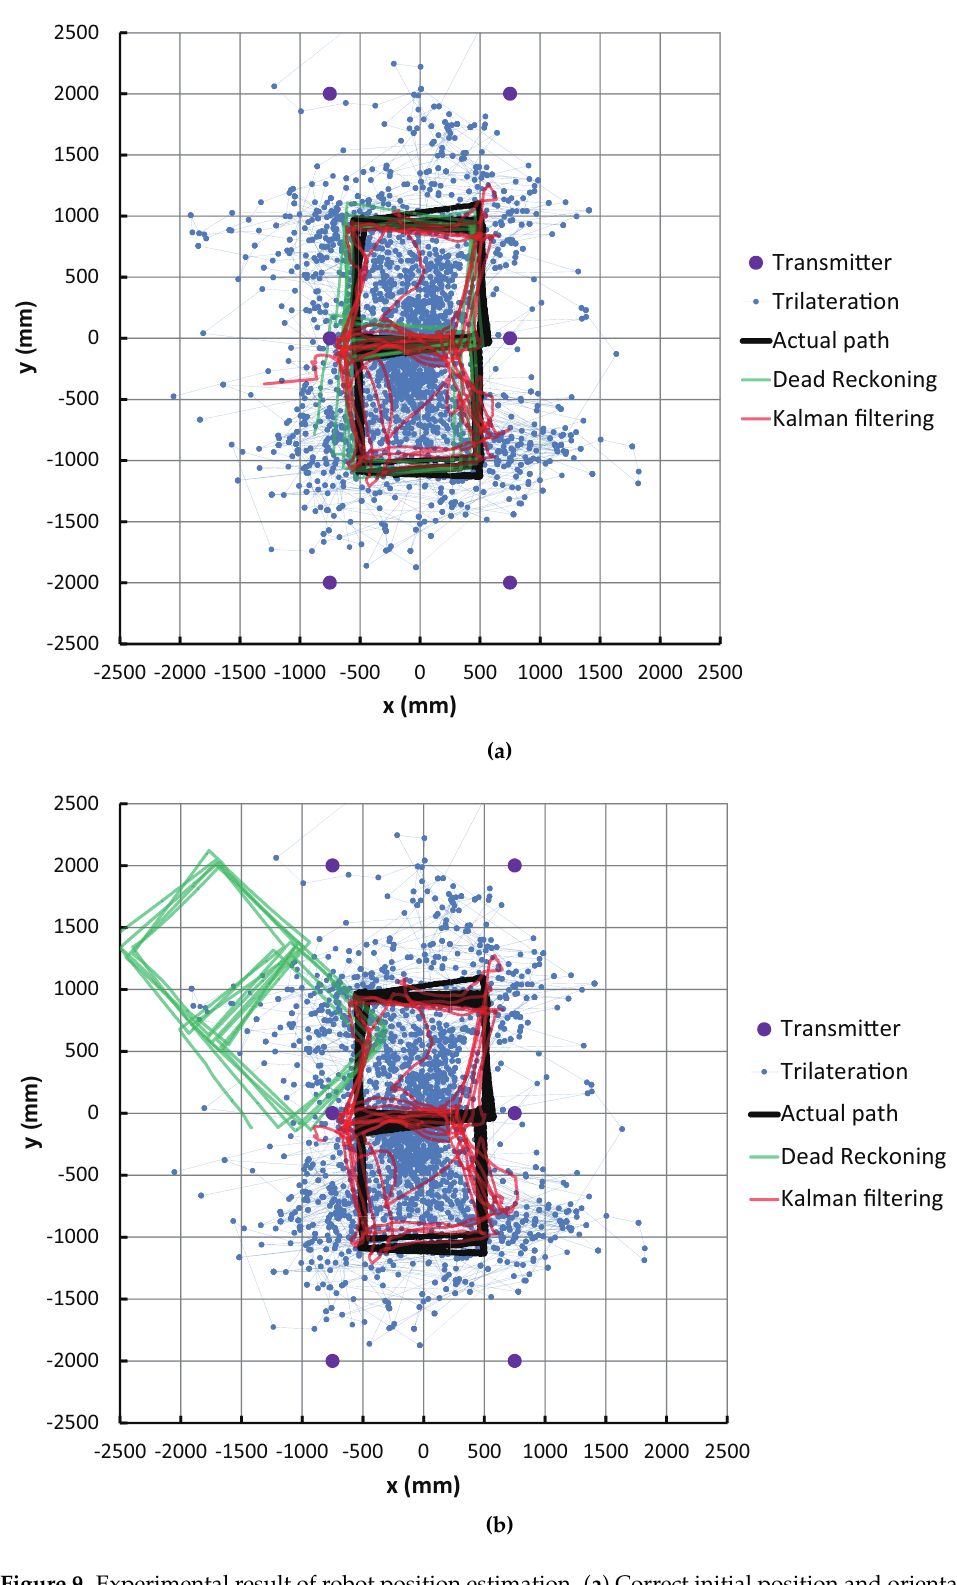
Figure 9. Experimental result of robot position estimation. ( a ) Correct initial position and orientation; ( b ) Incorrect initial position and